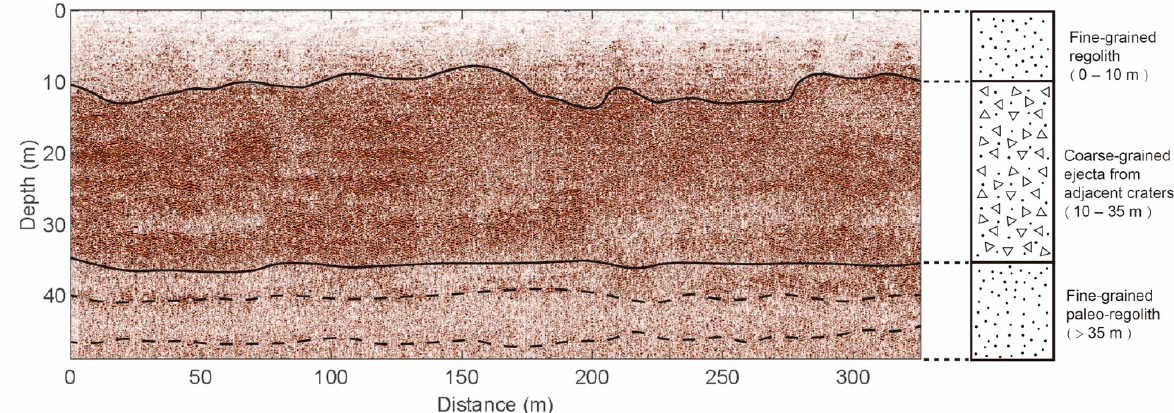
Figure 13. Stratigraphic divisions result and interpretation. The base of the figure is the radargram after CNN filtering. The vertical axis is the transformed depth from two-way traveling time with velocity assumed to 0.16 m/ns [11]. The radargram shows a fine-coarse-fine sandwich structure. The black curves indicate the interfaces of the sandwich structure. The dotted curves represent the interfaces of the sub-layers within the paleo-regolith.